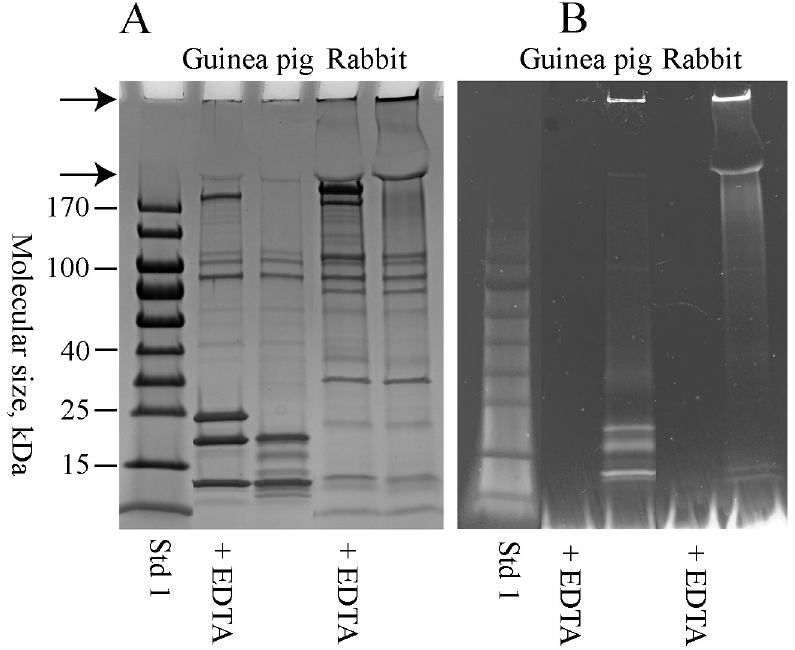
Fig 2. Transglutaminase treatment of seminal vesicle secretion. Guinea pig and rabbit samples were incubated with 1.5 mU of transglutaminase for 60 min at 37˚C in the presence of 1 mM dansylcadaverine. Control samples containing EDTA were run in parallel. The samples were reduced and subjected to SDS-PAGE on a 4–20% gradient SDS-PAGE gel run in Tris -glycine buffer, pH 8.3. In (A) the gel is stained for protein and in (B) it is exposed to UV-light in order to visualize the dansylcadaverine